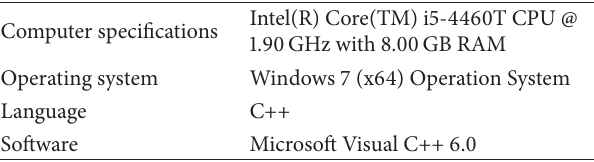
Table 4: Parameters of the simulation